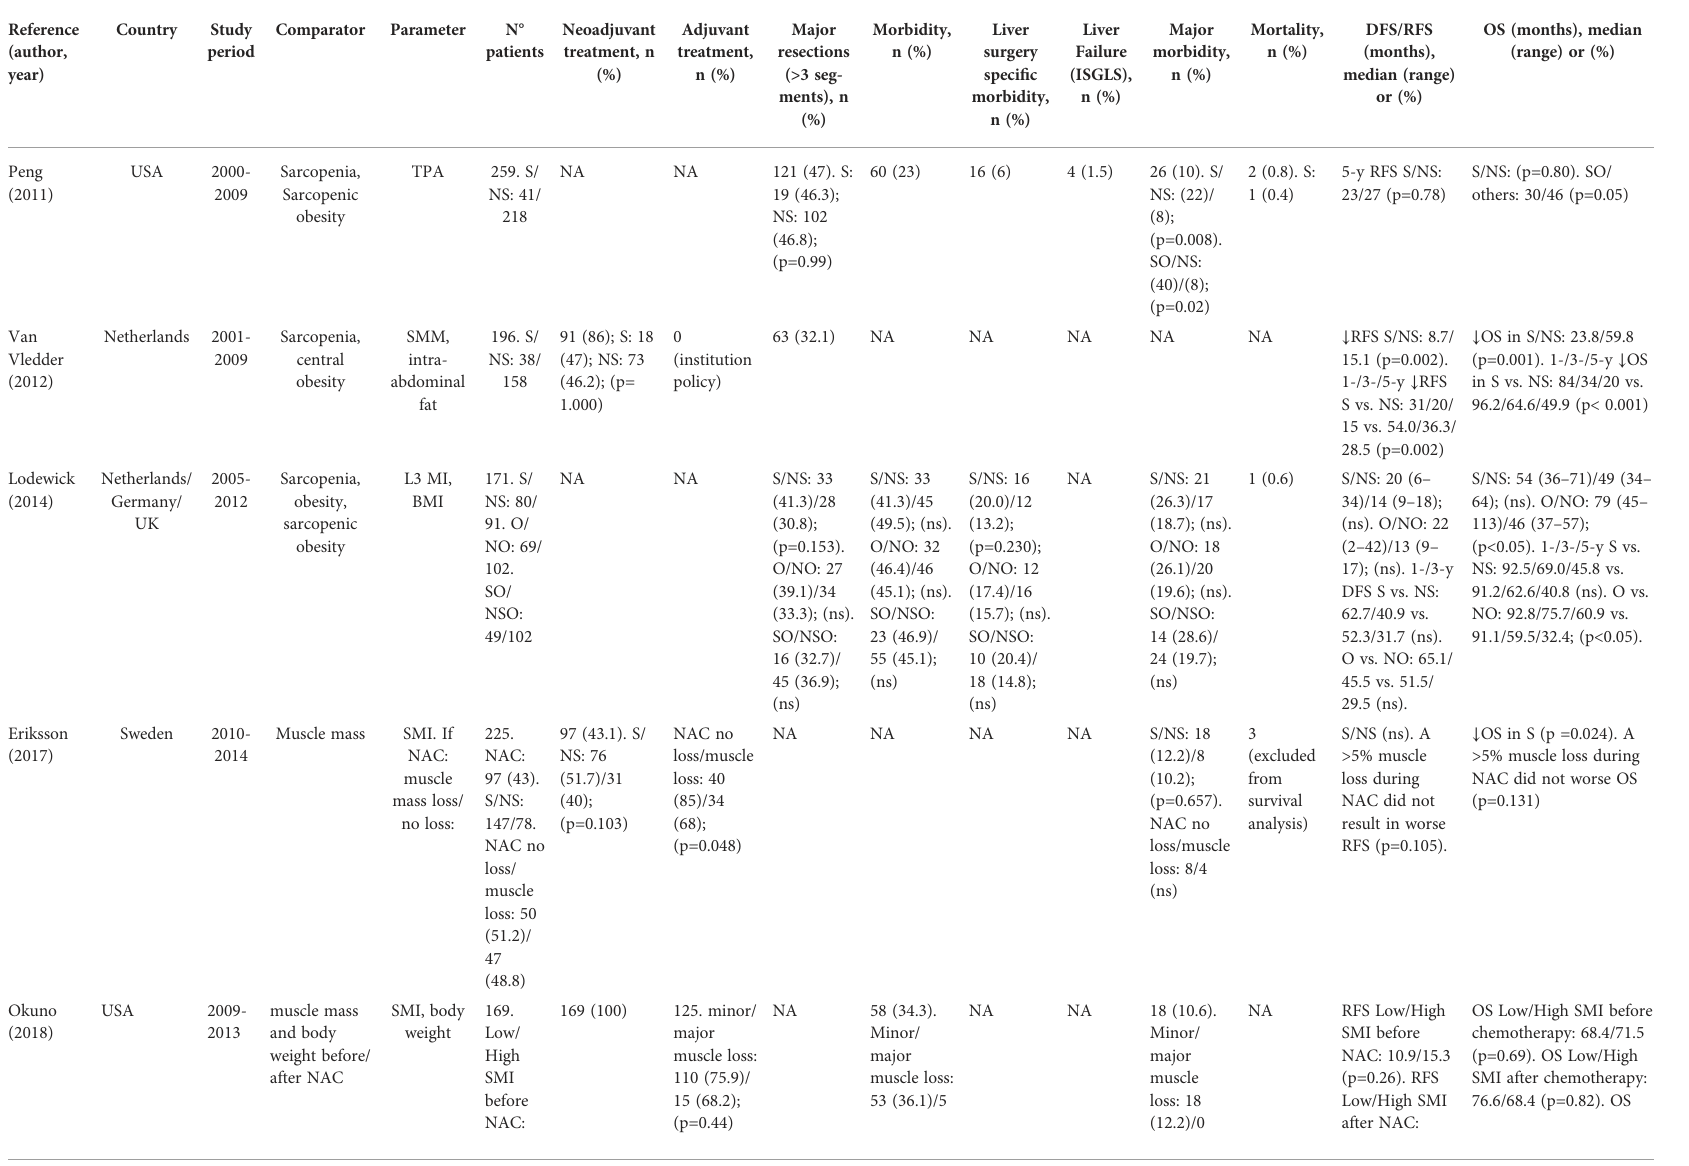
TABLE 5 Liver resection for colorectal liver metastases